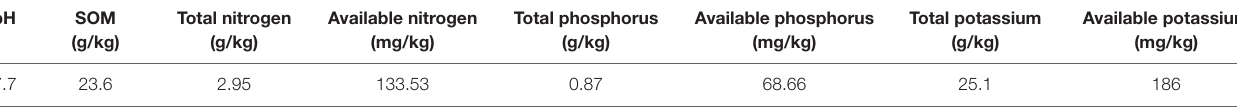
TABLE 1 | Physicochemical properties of the soils used in the experiment.